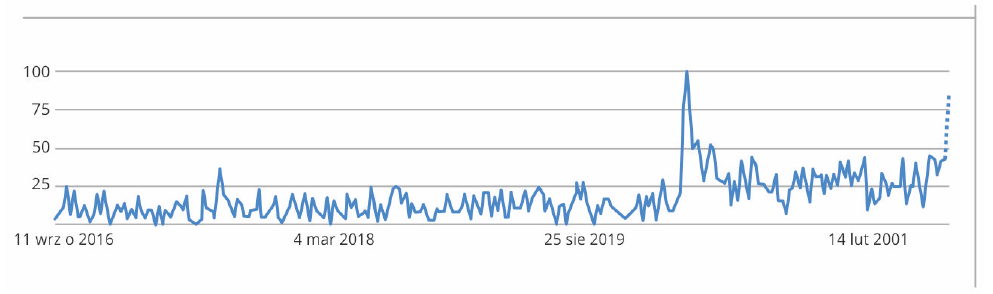
Figure 2. Keyword: “The Call of Jasna Góra” in 2016–2021; source: Google Trends, https://www.google.com/trends (accessed on 8 September 2021).